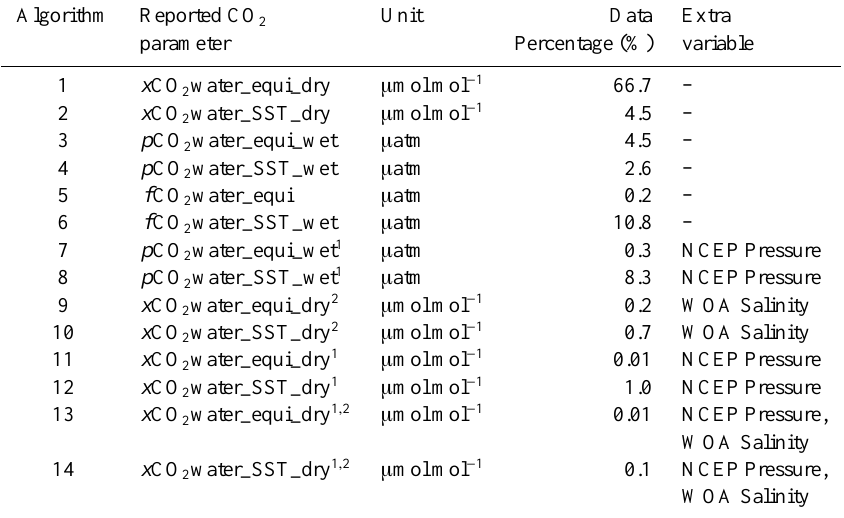
Table 8. Surface water CO 2 parameters used for the calculation of recommended f CO 2 ( f CO 2 rec) at sea surface temperature in version 2 (after Table 4 in Pfeil et al., 2013). The parameters are listed in order of preference (with algorithm 1 as the favourite). The algorithm is provided in the output files (Table 3). In cases of incomplete data reporting, these ancillary parameters have been used for atmospheric pressure and salinity: NCEP (National Centers for Environmental Prediction) atmospheric pressure (Kalnay et al., 1996) and WOA